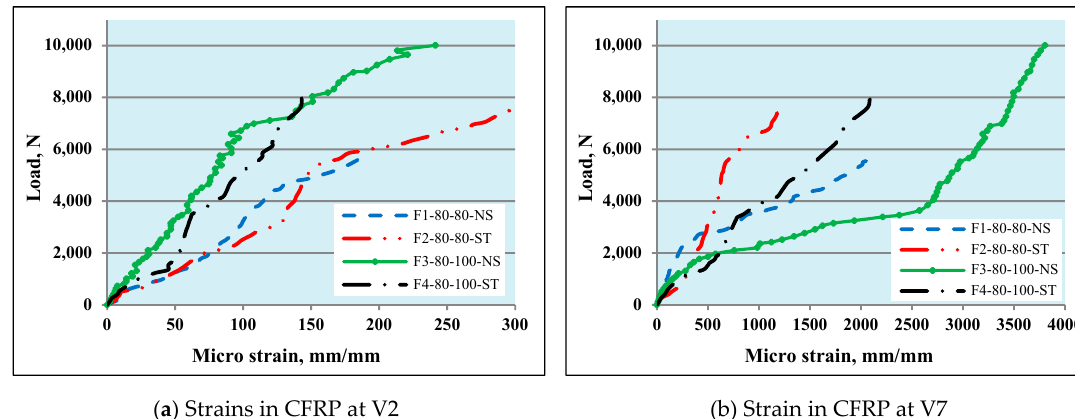
Figure 15. Load vs. tensile strain in fabrication CFRP.